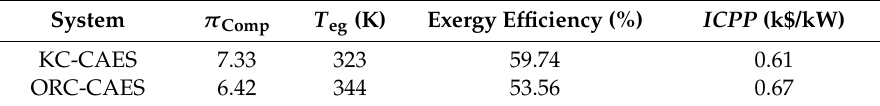
Table 2. Optimal parameters of the two systems.